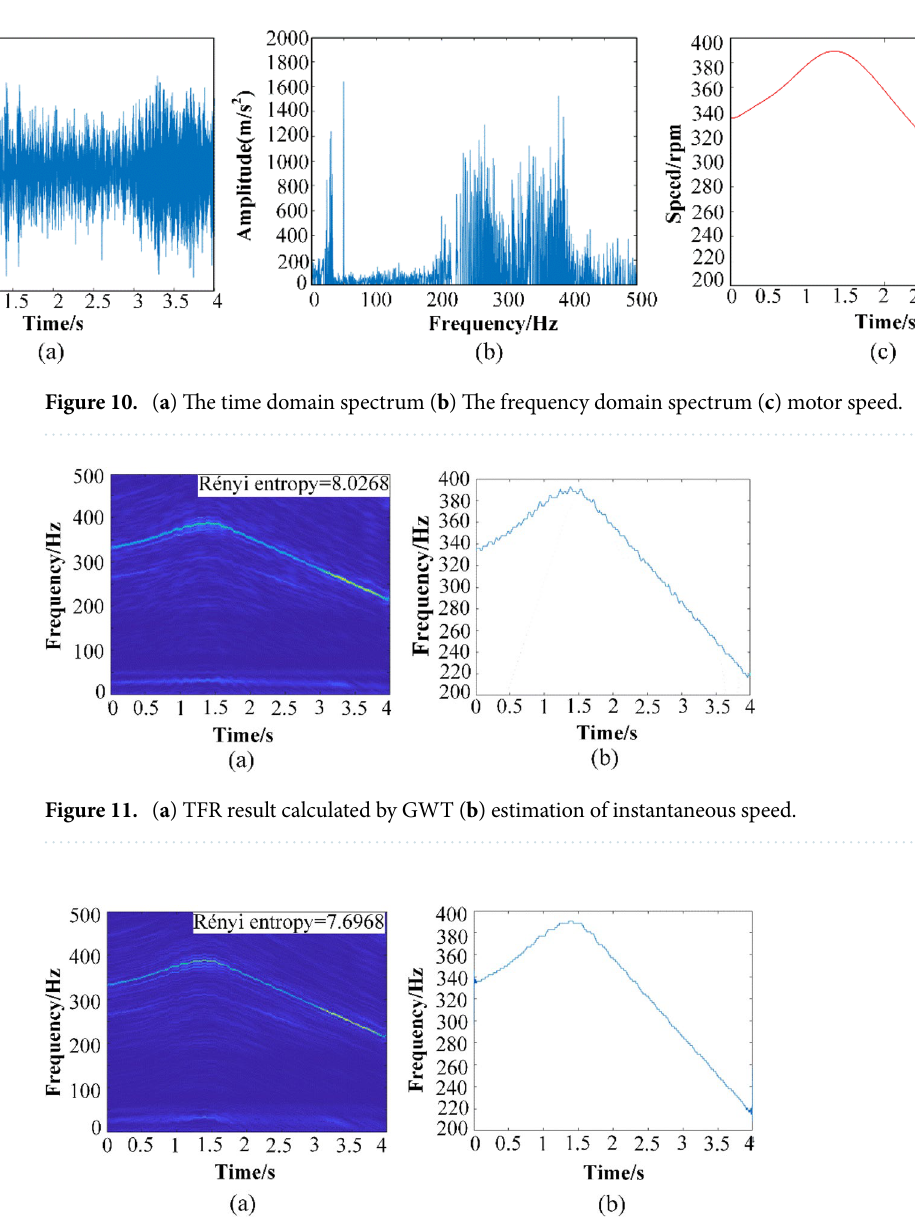
Figure 12. ( a ) TFR calculated by GWT–SSET ( b ) instantaneous speed